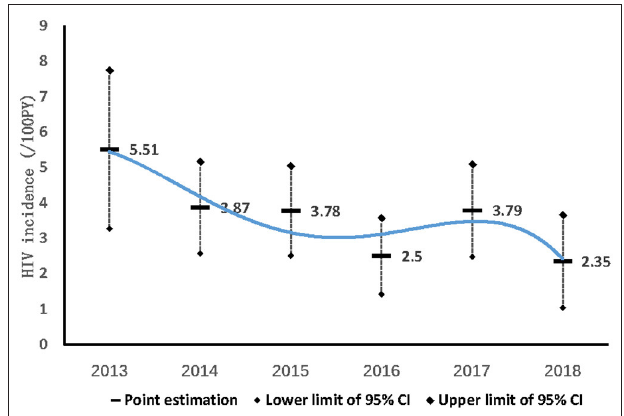
FIGURE 3 | Incidence of MSM in Harbin from 2013 to